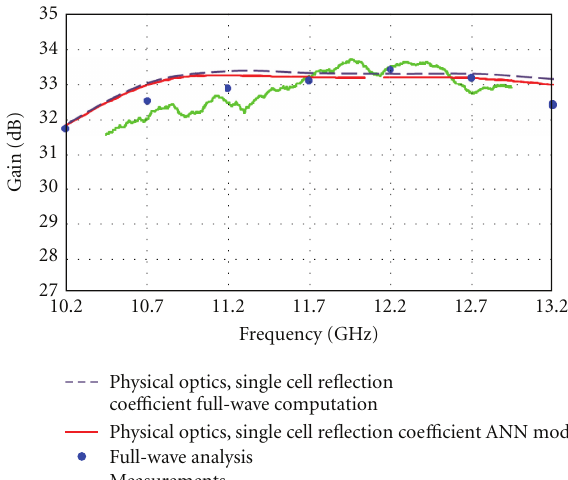
Figure 10: Variation of the maximum gain on the band 10.7–12.7 GHz for the RA with modified Malta Cross reradiating